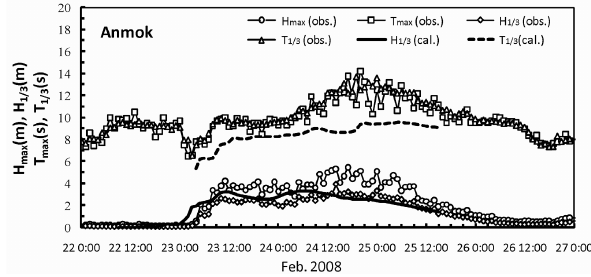
Fig. 16. Comparisons of observations and calculations of wave characteristics at Anmok in Korea for the event of February 2008.